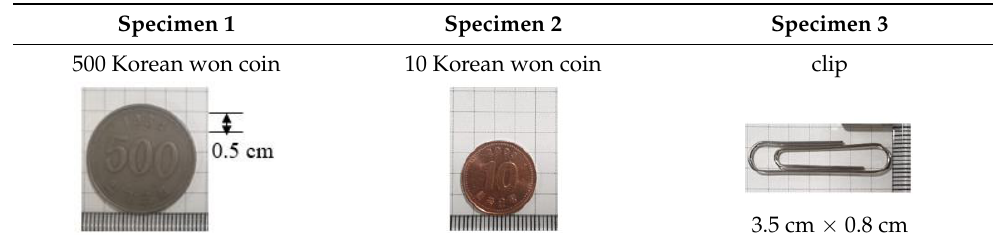
Table 1. Specimens of metal objects used in the experiment.